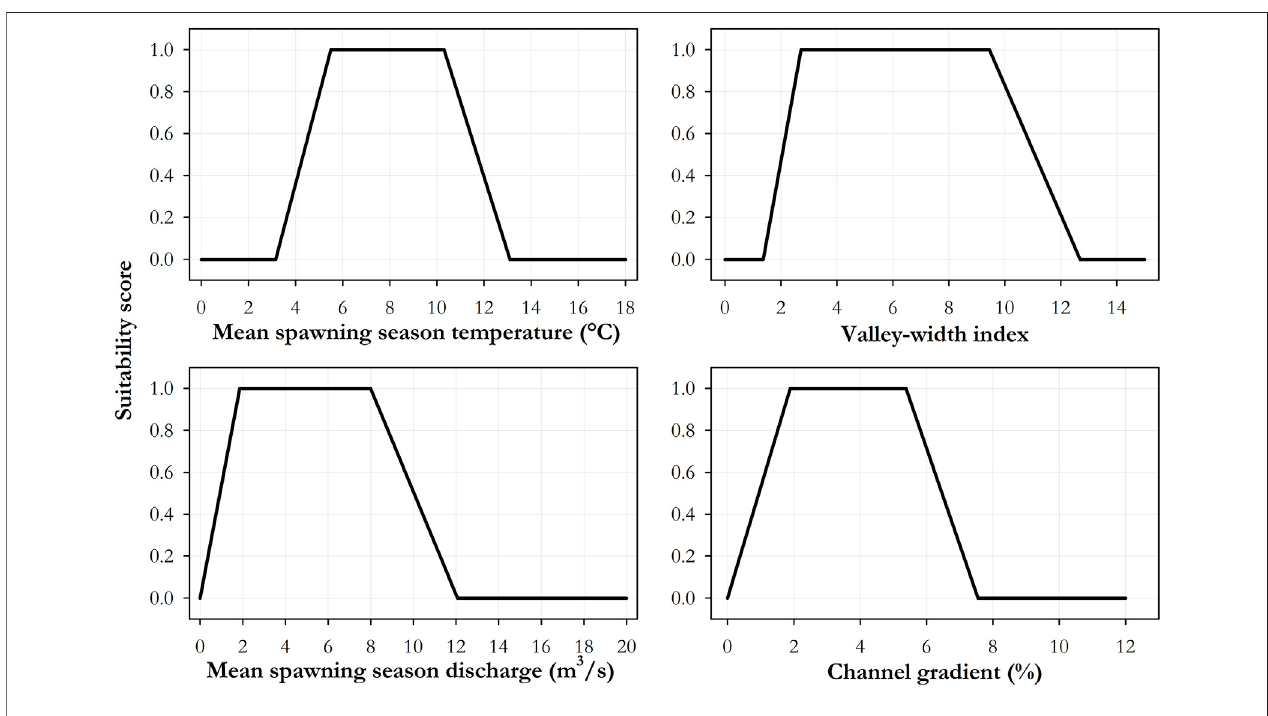
FIGURE 3 | Brook trout spawning habitat suitability indices.